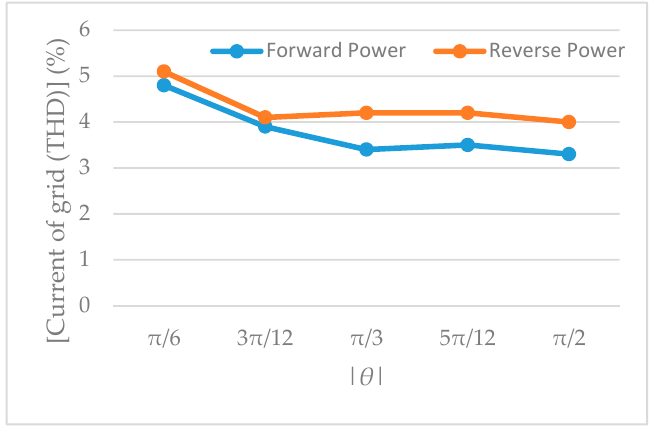
Figure 14. THD of grid current i a .